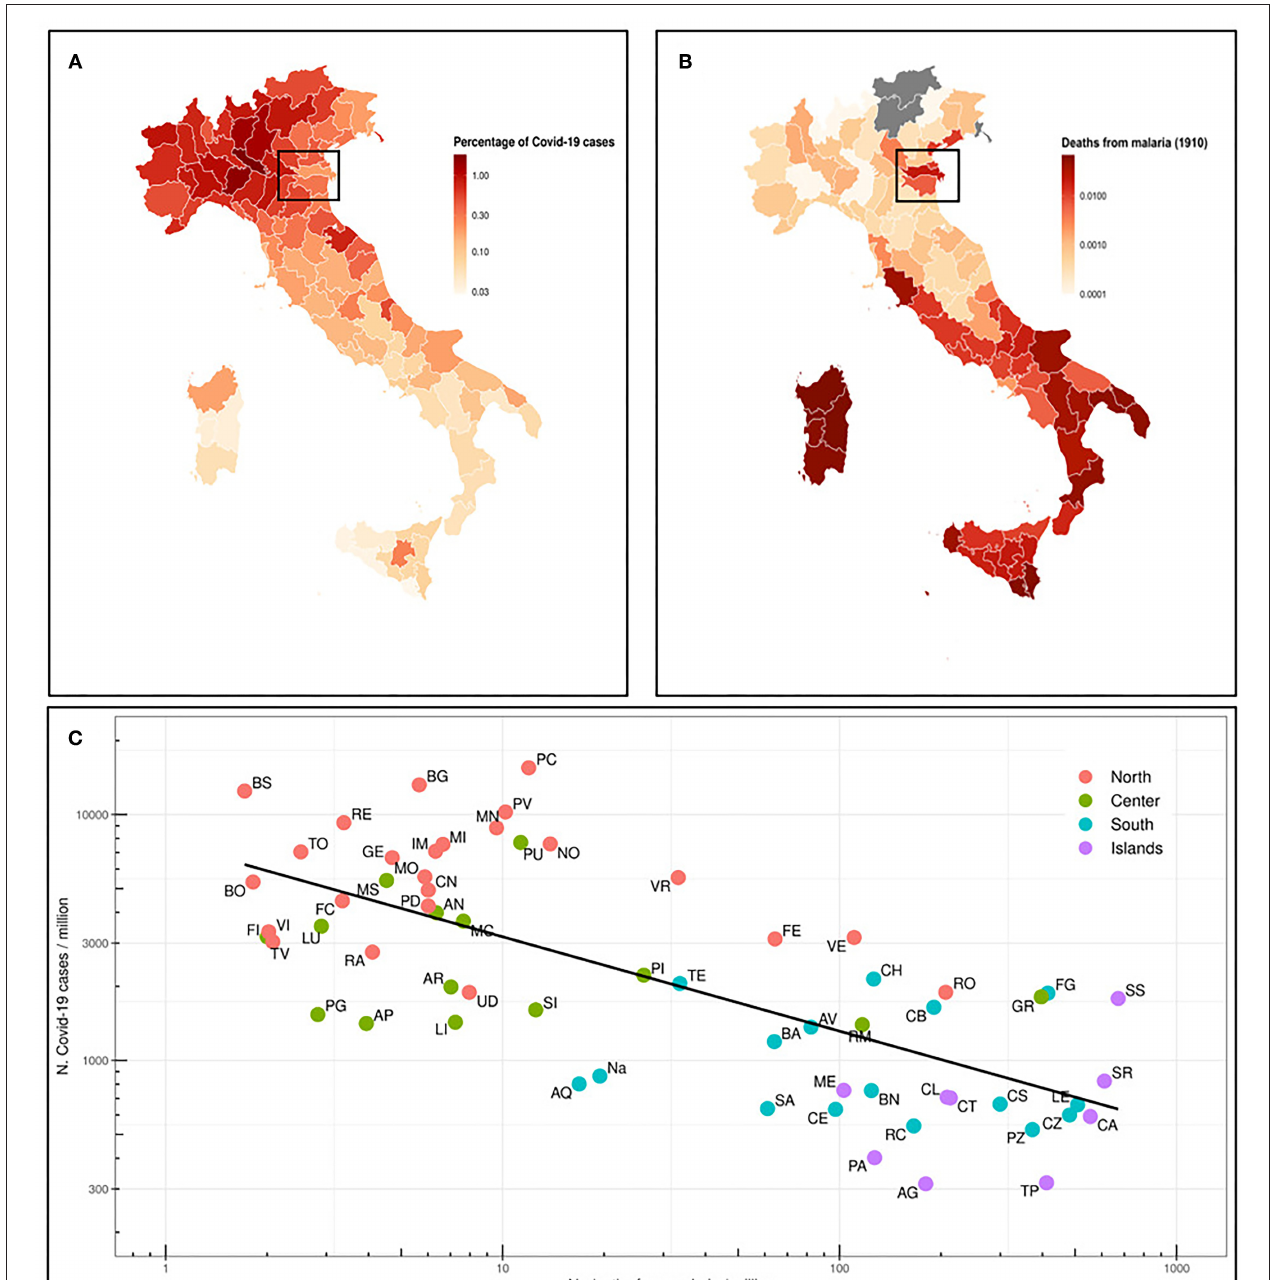
FIGURE 1 | (A) Map of the Italian provinces and representation as colorimetric scale of the percentage of deaths for malaria in 1910 (data not available for those provinces that were not included in the Italian Kingdom). The box highlights Ferrara and Rovigo provinces. (B) Map of the Italian provinces and the relative percentage of COVID-19 cases as n. COVID-19 cases/10 6 inhabitants in the province (situation on July 13th, 2020). (C) Prevalence of COVID-19 cases (n. cases/10 6 inhabitants) in Italian provinces (July 13th, 2020) vs. number of deaths from malaria in 1910. The regression line of log10 transformed values is shown. Spearman ρ = − 0.69 and p -value